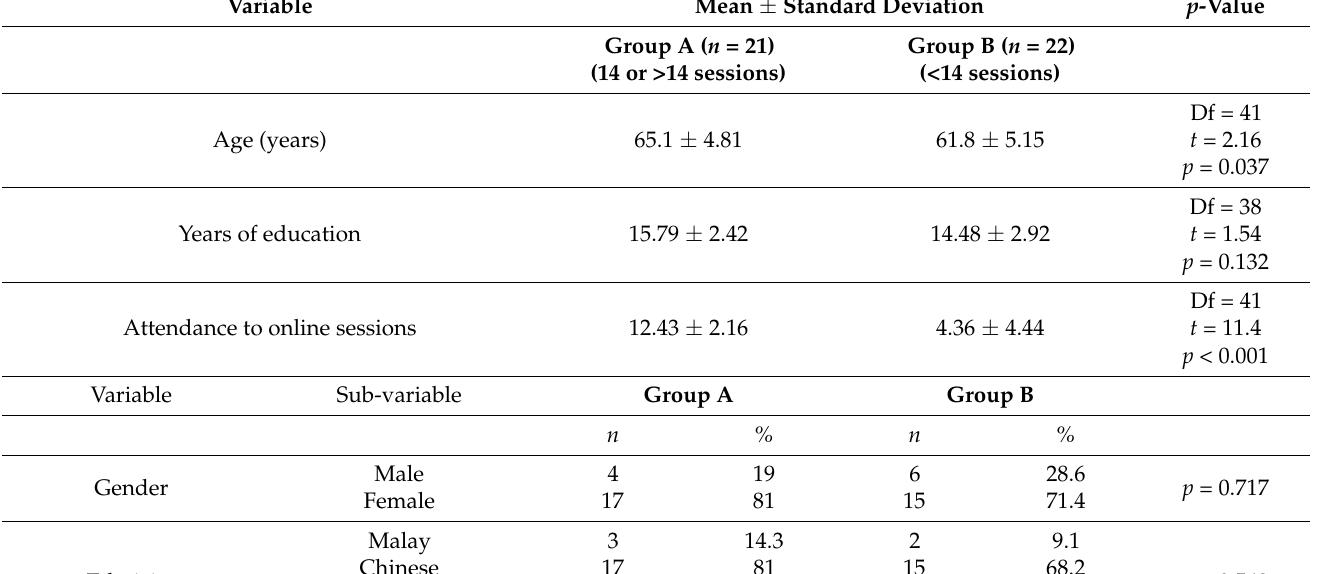
Table 1. Demographic characteristics of participants in Group A and Group